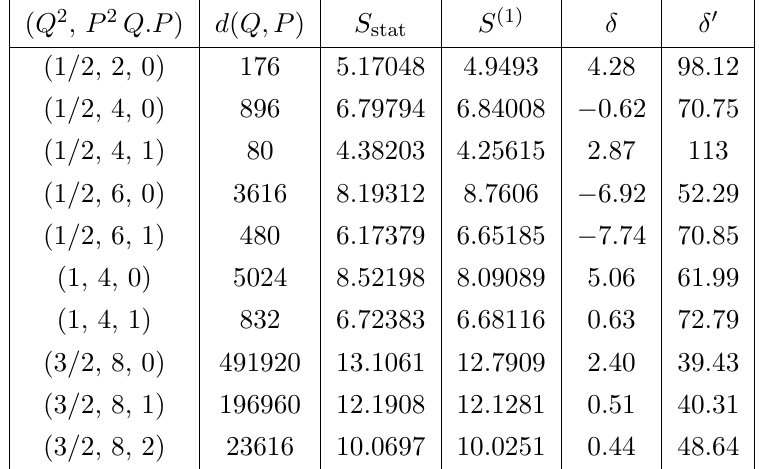
Table 11 . Comparison of the statistical entropy and statistical entropy at one loop for 4B orbifold.